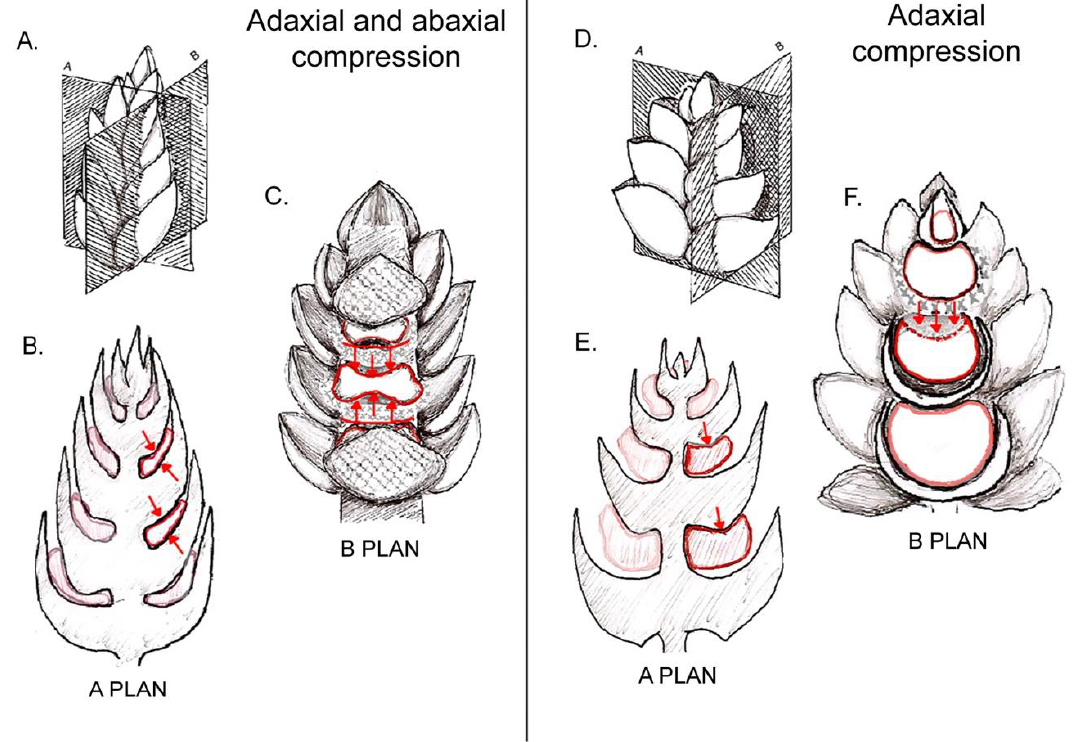
Figure 5. Examples of possible compression forces on floral primordia derived from subtending bracts and inflorescence axis: ( A ) scheme of an inflorescence bud and spatial orientation of sections shown in diagrams in B and C. ( B ) Longitudinal radial section (corresponding to plan A shown in A) showing squeezed floral primordia as a consequence of a “ sandwich ” effect caused by compress- ing bracts. ( C ) Longitudinal tangential section (corresponding to plan B shown in A) revealing the elongated shape of floral primordia due to both ad- and abaxial pressure from bracts. ( D ) Scheme of an inflorescence bud and spatial orientation of sections of it shown in diagrams in E and F. ( E ) Longitudinal radial section of inflorescence bud (corresponding to plan A shown in D) showing deformation on adaxial side of a floral primordium caused by its overlying bract. ( F ) Longitudinal section of inflorescence bud through plan B shown in D. Note that the oppressed adaxial zone of the primordium is not capable of producing floral organs. 3.1.1. Compression and Flattening of the Flower Bud A tight pressure of the inflorescence bracts can mold monosymmetric lateral buds (Figure 5B,C), as seen in the flowers of Euptelea (Eupteleaceae, Figure 6A) [7,21,22], Noto- buxus (Buxaceae, Figure 6B) [23] or Drymis (Winteraceae, Figure 6C,D) [24]. Similarly, the tetragonal lateral flowers that occur in Bataceae and Salvadoraceae seem to be a direct consequence of the compression of their floral meristem between bract and inflorescence axis [25,26]. In inflorescences that possess terminal flowers, this phenomenon is especially mani- fested since terminal flowers are not squeezed by a subtending bract as they develop di- rectly from the transformation of the inflorescence meristem [27]. For example, terminal and lateral flowers of Styloceras and Notobuxus (Buxaceae) differ in shape and sex distri- bution [23]. Lateral flowers in Drymis (Figure 6C,D) [24] present lower floral organ num- ber and an altered phyllotaxis. There is also a different merism in lateral versus terminal flowers of Trochodendron, Ruta, Adoxa, among others [10,22]. In Poales, there is also evidence of organ variation due to tight pressures of subtend- ing bracts. Here, floral reductions are documented in correspondence with a shift to wind pollination correlated with tight inflorescences and a carpel reduction and loss. These take place mainly in a median direction, suggesting a flattening of the floral primordium by the subtending bracts (e.g., Restionaceae [28]; Poaceae [29]). Also, Reynders et al. [30]